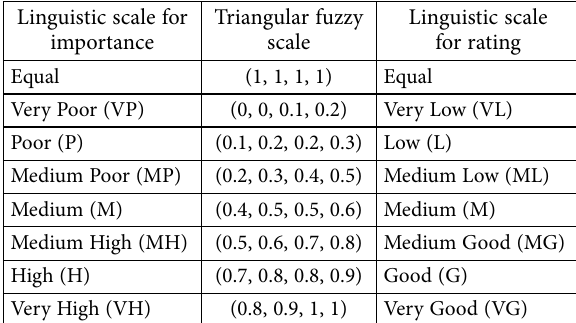
Table 2. Linguistic scales for importance and rating (Liu et al. 2012) Linguistic scale for Triangular fuzzy Linguistic scale importance scale for